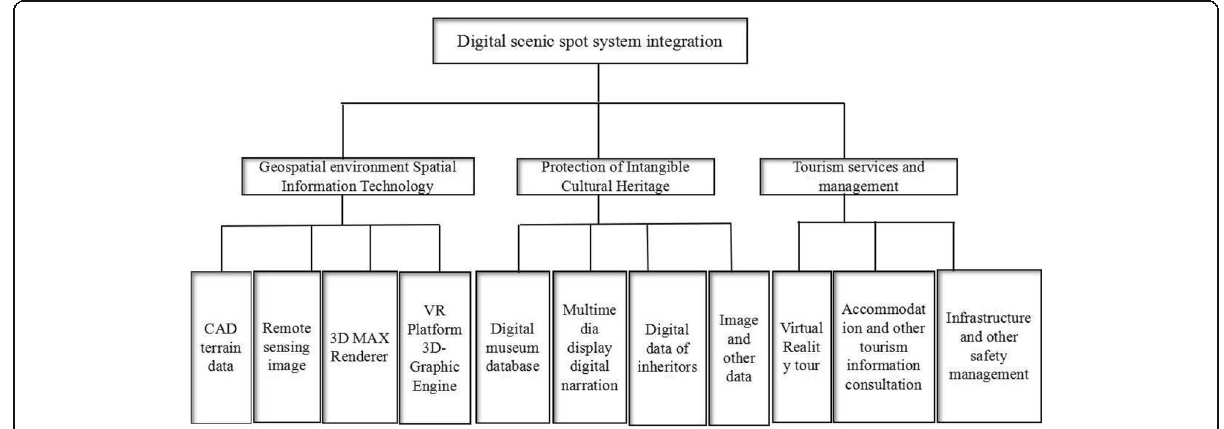
Fig. 3 Digital tourist attraction system integration map